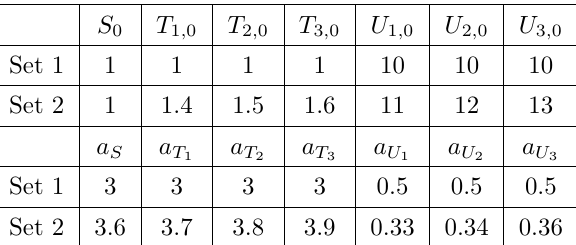
Table 5 . Two choices of the parameters for the seven-moduli model. In addition, we take f 6 = 1 p for Set 1, while f 6 = 3 = 2 for Set 2.